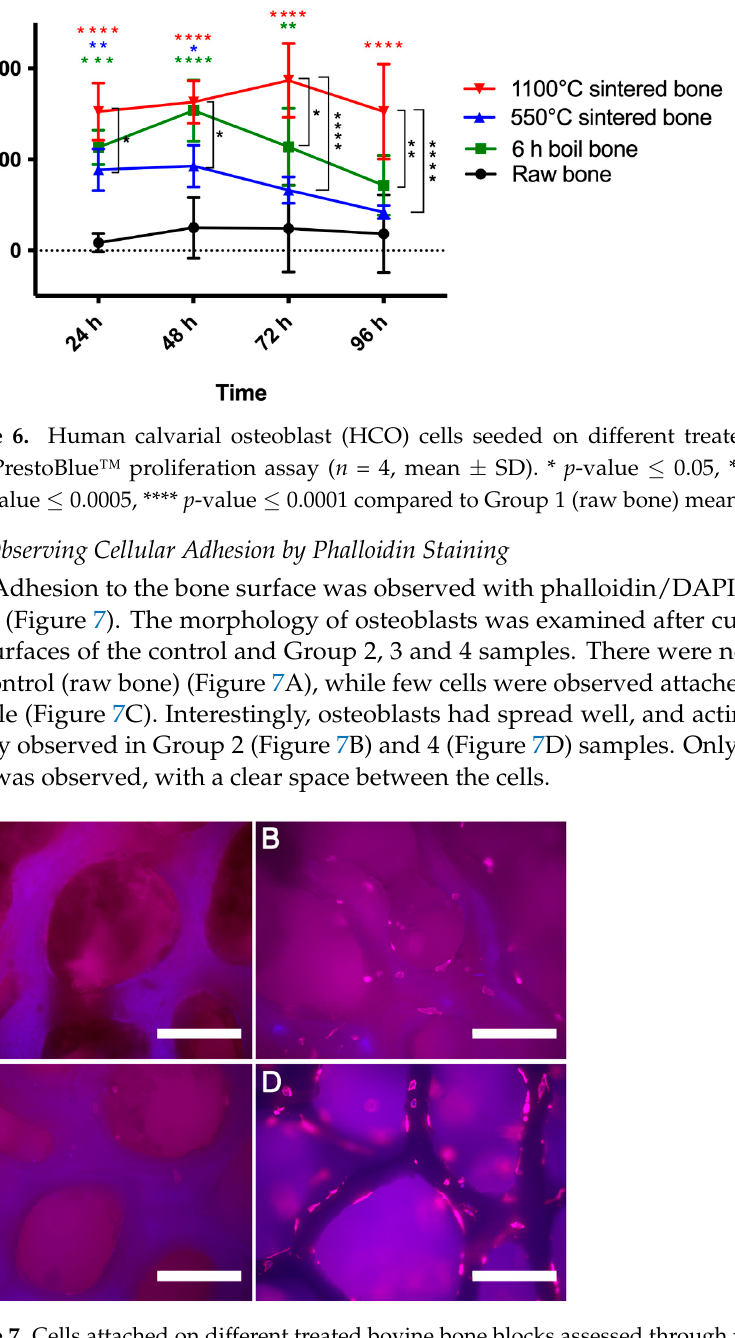
Figure 5. Testing the ability of the bone block to withstand fracture during placement of a bone screw. ( A ) Raw bone, ( B ) boil (6 h), ( C , E , G ) initial boiling (6 h) followed by 550 °C sintering (6 h),